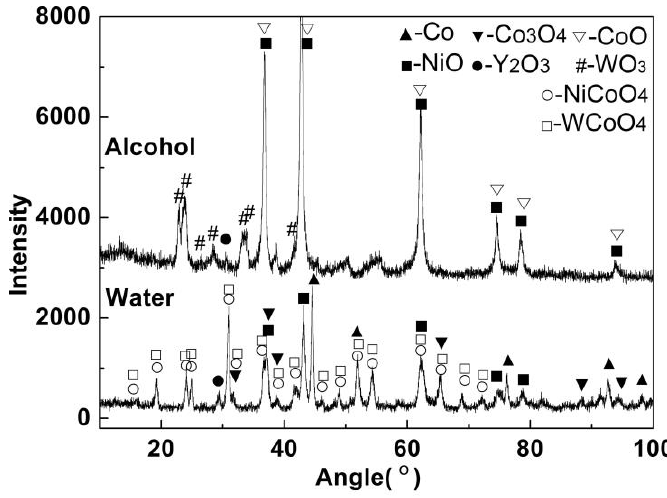
Figure 4. X-ray di ff usion (XRD) patterns of the combusted powder prepared in di ff erent Figure 4. X-ray diffusion (XRD) patterns of the combusted powder prepared in different media.